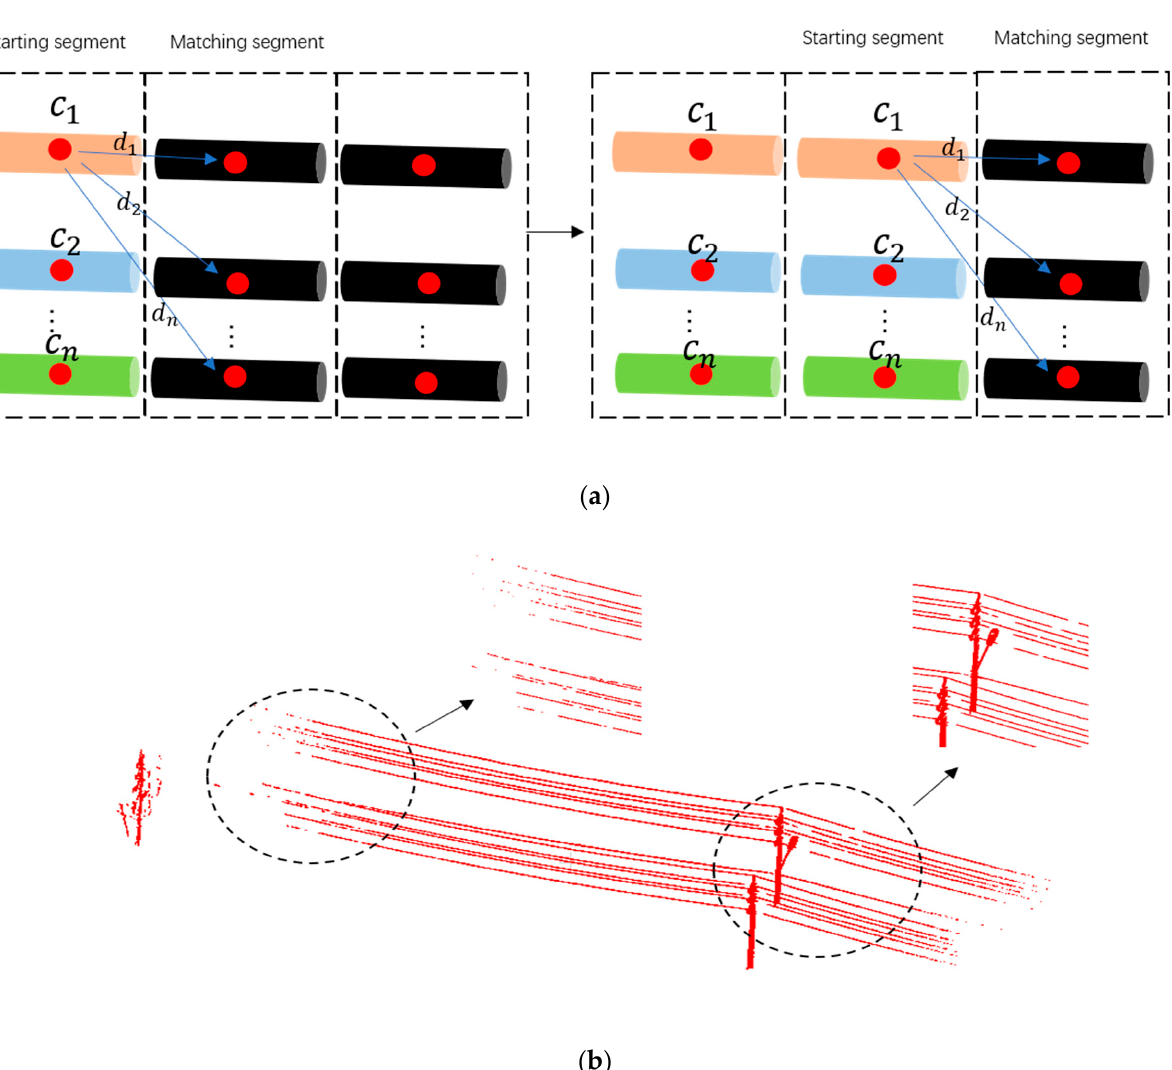
Figure 8. Example of candidate clustering and gaps. ( a ) Clustering between the starting segment and matching segment (take the clustering process of c 1 as an example. Black cylinders are powerline candidates in matching segments, c 1 – c n are labeled powerline candidates in the starting segment, red points are centroids of powerline candidates, and d 1 – d n are the distance between the centroids). ( b ) Gaps in the preprocessed data.